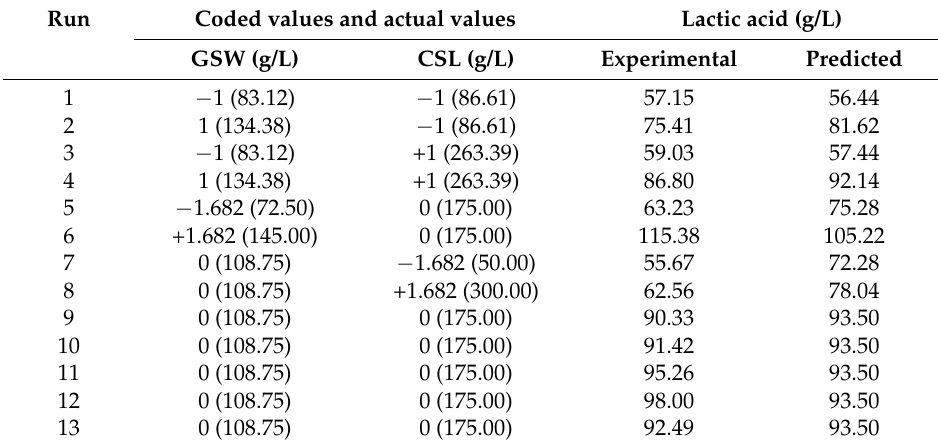
Table 3. The CCD experimental design matrix with experimental and predicted values of lactic acid production at 37 ◦ C under static conditions for 18 h.